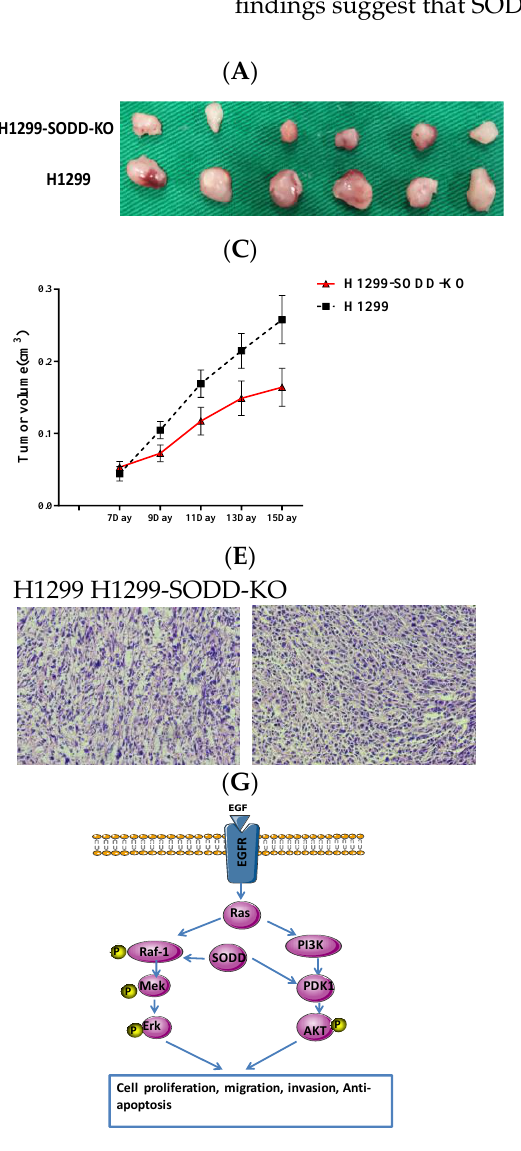
Figure 6. SODD knockout inhibits H1299 cell tumorigenicity in a nude mouse xenograft model ( A ) Two groups of excised tumors from nude mice injected with SODD-KO H1299 and H1299 cells. ( B ) The statistical difference in the tumor masses from the two groups (*** p < 0.001). ( C , D ) The difference in the tumor volume and body weight between two groups of mice ( E ) Hematoxylin and eosin (HE) staining of tumors from the two groups. ( F ) PDK1 staining of tumors from the two groups. ( G ) The indicated roles of SODD in the RAF-1/MEK/Erk and PI3K/PDK1/AKT